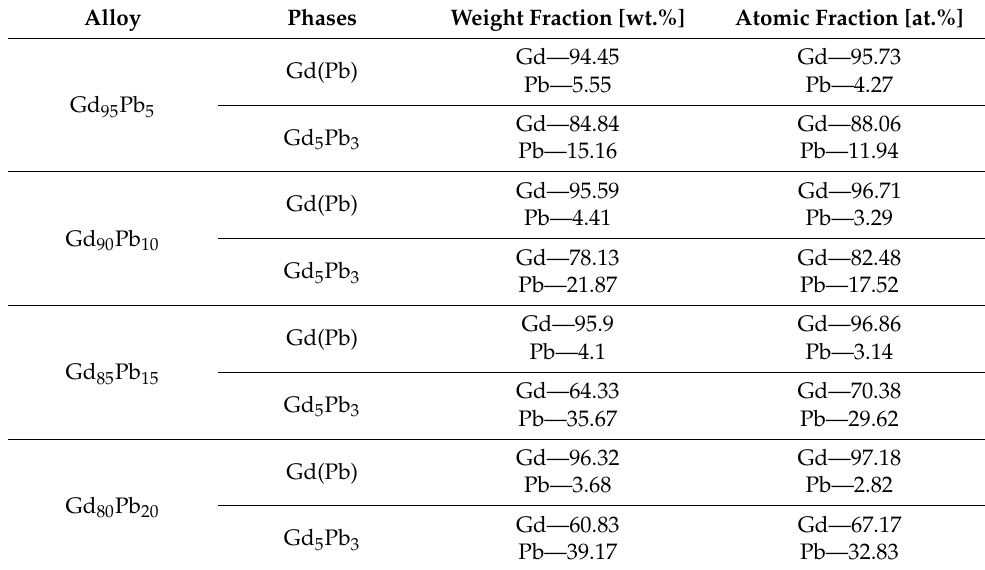
Table 2. Chemical composition of recognized phases in all studied alloys. Alloy Phases Weight Fraction [wt.%] Atomic Fraction